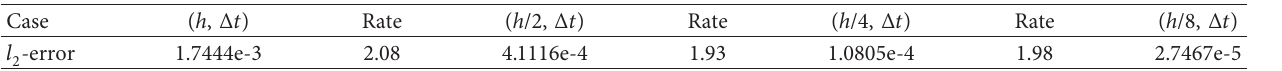
Table 12: Convergence test results of the unconditionally stable method for space step.